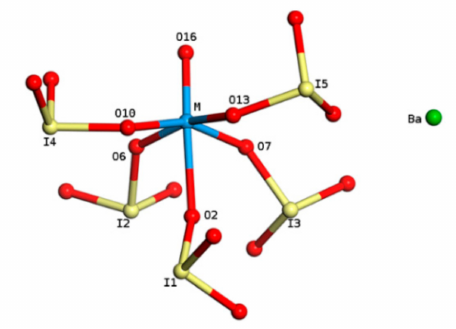
Figure 1. Atom structure of a BaMO(IO 3 ) 5